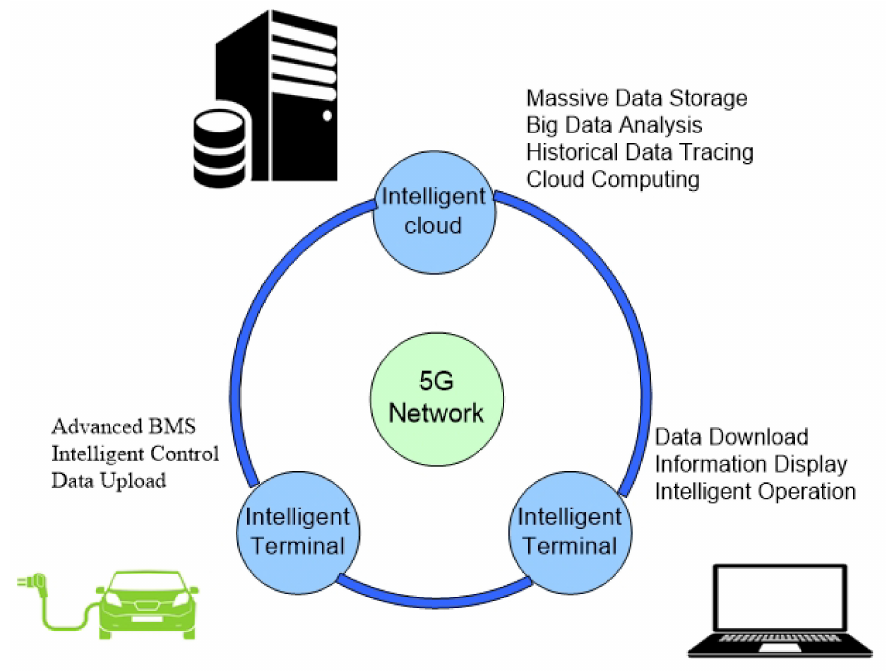
Figure 7. Advanced battery-management system architecture with